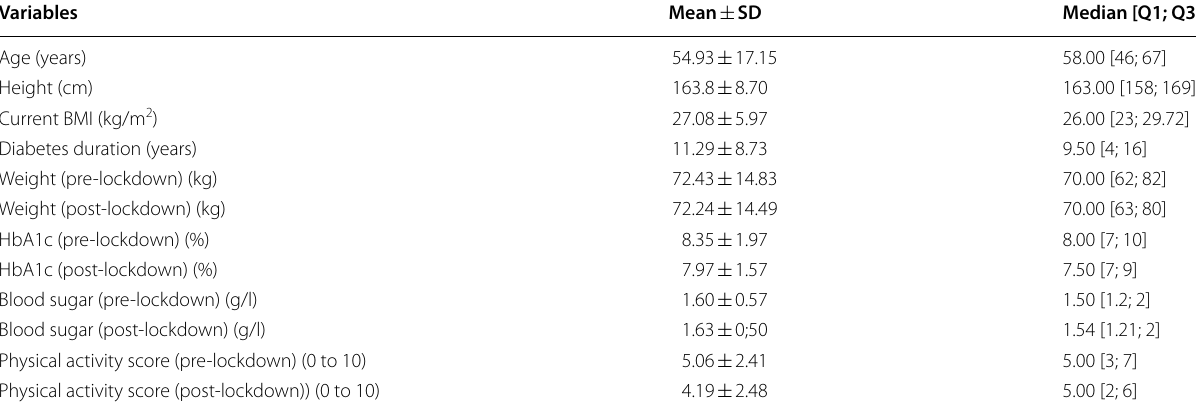
BMI body mass index, HbA1c glycated hemoglobin, SD standard deviation, Q